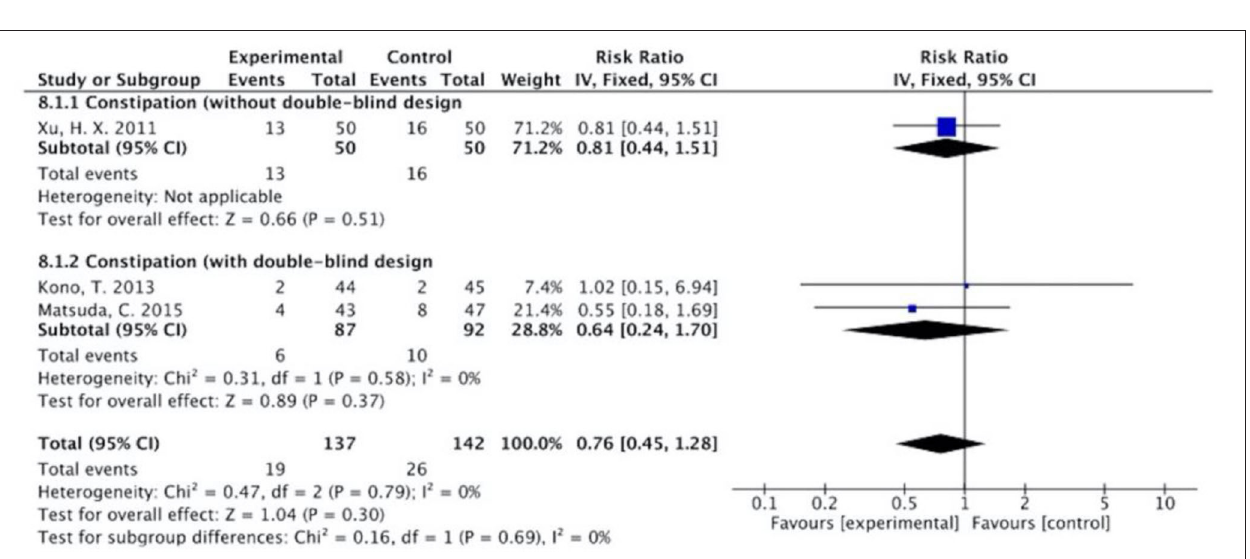
+ A. membranaceus , and G. uralensis + A. macrocephala